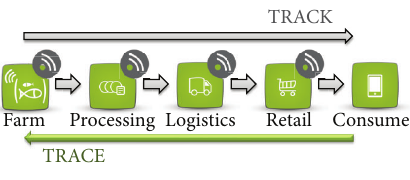
Figure 3: Fish supply